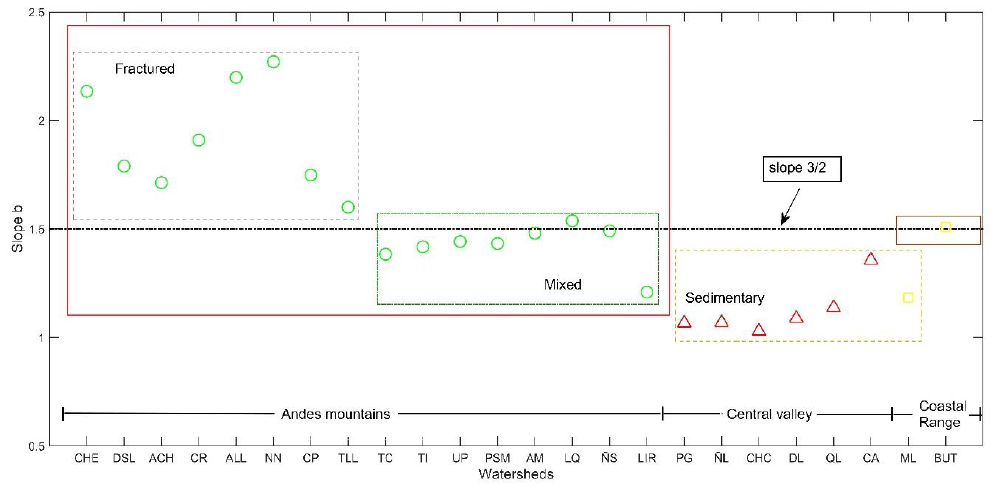
Figure 4. Slope b obtained by least squares applied to the data bins.